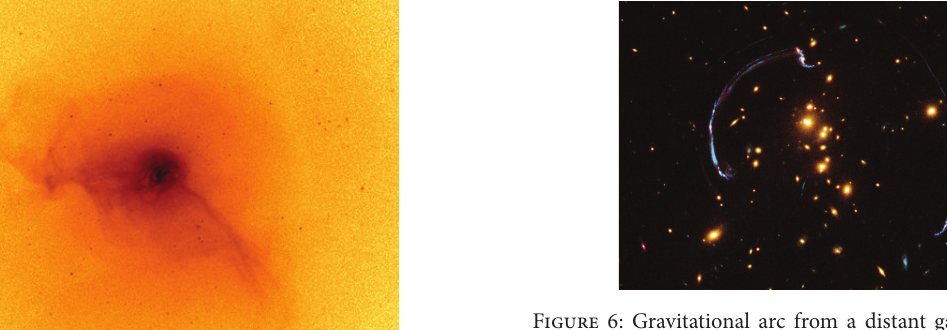
Figure 6: Gravitational arc from a distant galaxy behind a fore- ground galaxy cluster [36]. Credit: NASA, ESA, and A. Gonzalez (University of Florida, Gainesville), A. Stanford (University of California, Davis and Lawrence Livermore National Laboratory), and M. Brodwin (University of Missouri-Kansas City and Harvard- Smithsonian Center for Astrophysics) The giant arc, an incomplete Einstein Ring shown is an example of strong gravitational